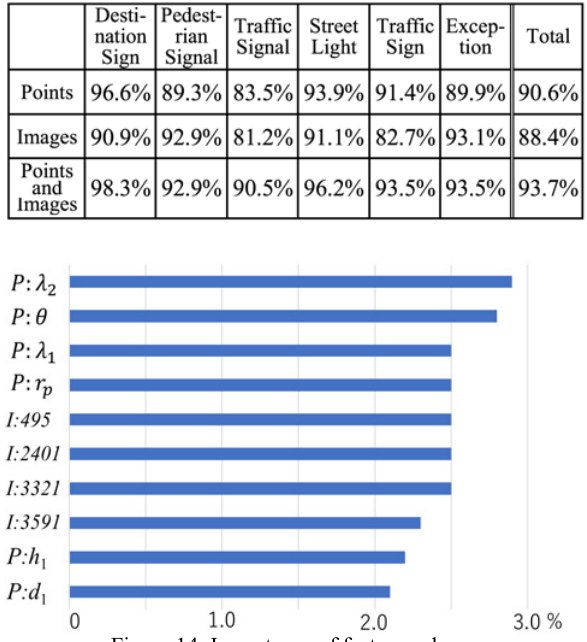
Table 6. F-measure of classified objects